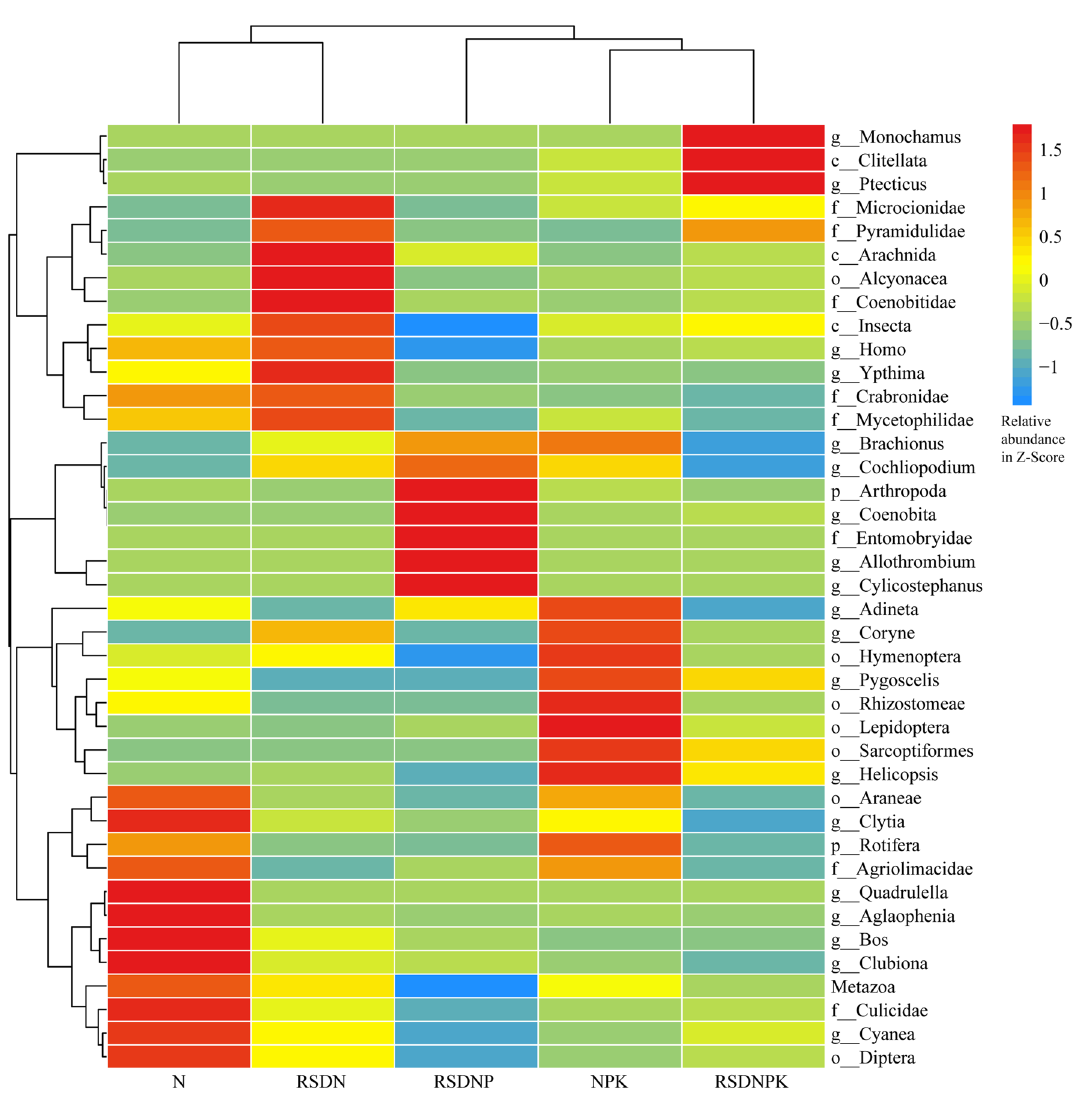
Figure 1. Heatmap of the top 40 abundant soil faunal taxa based on genus level under different fertilization regimes. N synthetic N fertilizer, NPK synthetic fertilizer: nitrogen, phosphorus and potassium, RSDN crop residues returned with nitrogen, RSDNP crop residues returned with nitrogen and phosphorus, RSDNPK crop residues returned with nitrogen, phosphorus and potassium. When the genus was unclassified, the corresponding higher-level annotation was adopted and denoted by f — , o — , c — , or p —